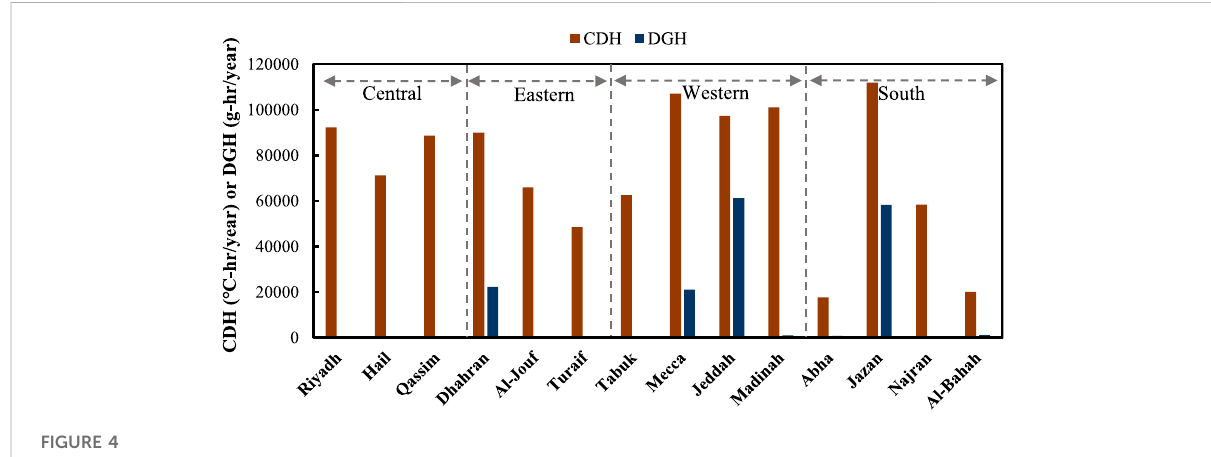
FIGURE 4 CDH and DGH for representative cities of Saudi Arabia.